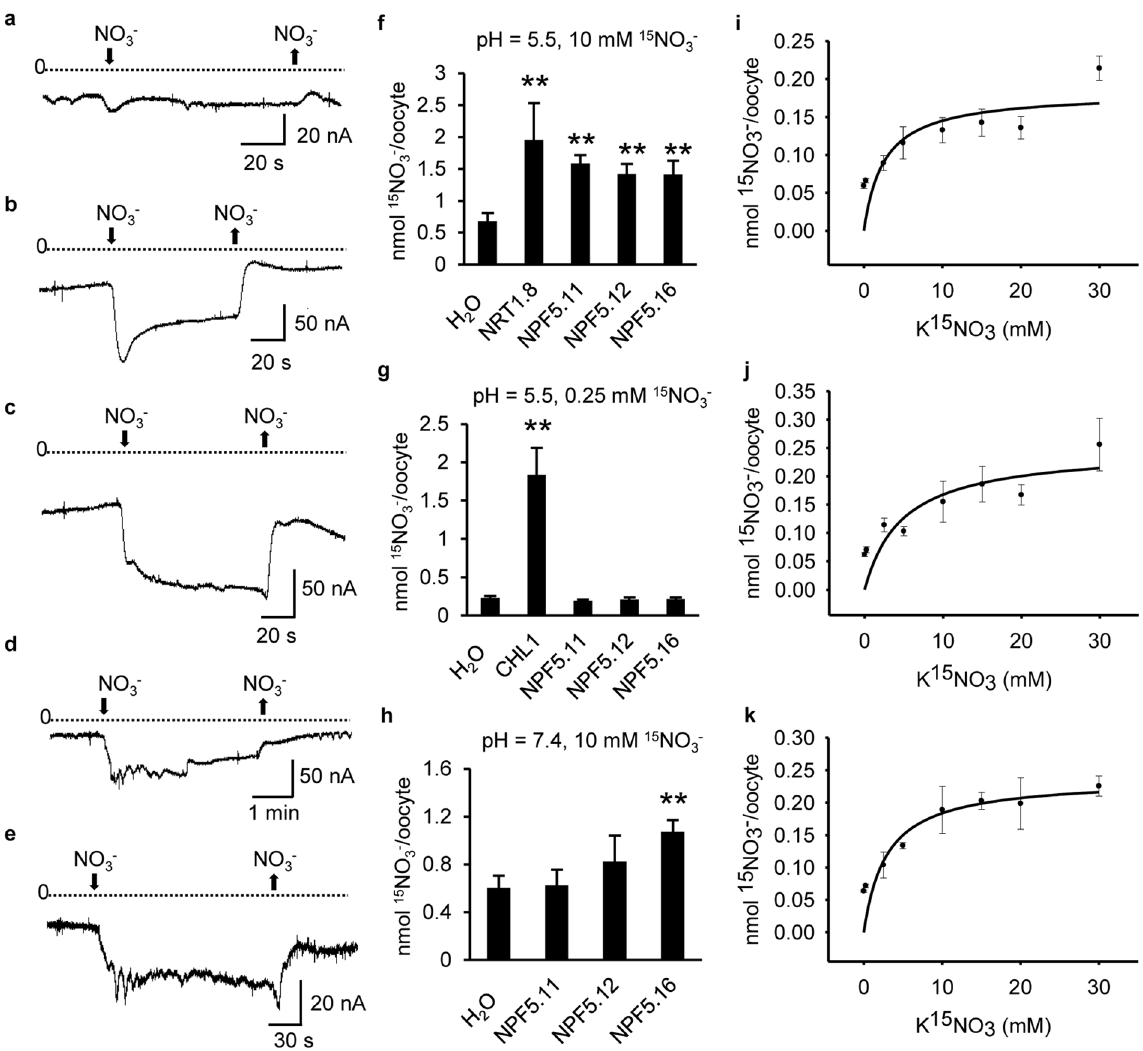
Figure 2. Functional characterization of NPF5.11, NPF5.12 and NPF5.16 in oocytes. ( a – e ) Currents elicited in oocytes injected with H 2 O ( a ), CHL1 cRNA ( b ), NPF5.11 cRNA ( c ), NPF5.12 cRNA ( d ) or NPF5.16 cRNA ( e ). Oocytes were voltage clamped at − 60 mV and representative inward currents elicited by 10 mM NO 3 − at pH 5.5 were recorded. ( f – h ) Nitrate uptake activity in oocytes injected with H 2 O, NPF5.11 cRNA, NPF5.12 cRNA, NPF5.16 cRNA, NRT1.8 cRNA or CHL1 cRNA. Oocytes were incubated with 10 mM 15 NO 3 − at pH 5.5 ( f ), 0.25 mM 15 NO 3 − at pH 5.5 ( g ) or 10 mM 15 NO 3 − at pH 7.4 ( h ) for 12 h. Values are means ± SD (n = 8–12). Asterisks indicate difference at P < 0.01 ( ** ) compared with the H 2 O-injected oocytes by Student’s t -test. ( i – k ) Uptake kinetics of NPF5.11 ( i ), NPF5.12 ( j ) and NPF5.16 ( k ). Oocytes injected with NPF5.11 cRNA ( i ), NPF5.12 cRNA ( j ) or NPF5.16 cRNA ( k ) were incubated with indicated concentrations of 15 NO 3 − at pH 5.5 for 1.5 h, and the 15 N contents were determined. Values are means ± SD (n = 6–12). The K m was calculated by fitting to the Michaelis-Menten equation using a nonlinear least squares method in the SigmaPlot program. The K m was 2.57 mM, 4.84 mM, or 2.91 mM for NPF5.11, NPF5.12 or NPF5.16,